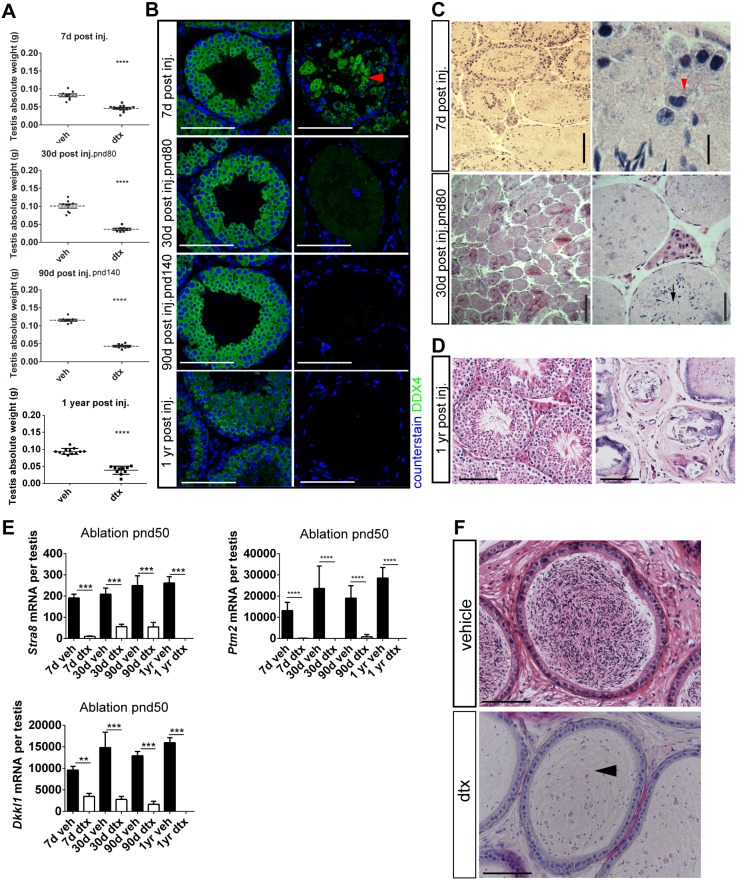
Germ cell loss after Sertoli cell ablation in adulthood does not impact testicular architecture.(A) Testis weight is decreased at all ages following Sertoli cell ablation in adulthood (T-test n = 8–12, ****P<0.0001). (B) Immunolocalization of DDX4 shows loss of Germ cells is complete 30 days following Sertoli cell ablation (scale bar: 100 µm). (C) Testicular histology (2.5 µm resin sections stained with hematoxylin and eosin) shows that intact tubules, containing spermatogonia, spermatocytes and spermatids, are present 7 days following Sertoli cell ablation although many of the spermatocytes (red arrowhead) are undergoing apoptosis. By 30 days the lumen of most tubules are either acellular or contain only elongated spermatids (black arrow). Low and high power pictures from treated animals are shown at each age. (D) Image on the right shows that one year after ablation tubular architecture is retained although the seminiferous tubules contain only calcium deposits and some elongated spermatids. The image on the left is a from a control, age-matched testis. (E) Expression of Germ cell markers Stra8 and Dkkl1 and Ptm2 (one-way ANOVA n = 5–9, **P<0.05 ***P<0.001 ****P<0.0001). (F) Consistent with Germ cell loss, Cauda epididymides are devoid of spermatozoa and only cellular debris remains 30 days post Sertoli cell ablation (arrowhead) (scale bar: 100 µm). d,days; yr,year; dtx, injected with toxin; veh: vehicle control.